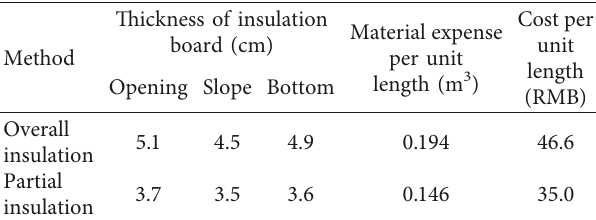
Figure 16: Antifrost effect of the insulation board. Table 6: Physical indexes for the EPS insulation